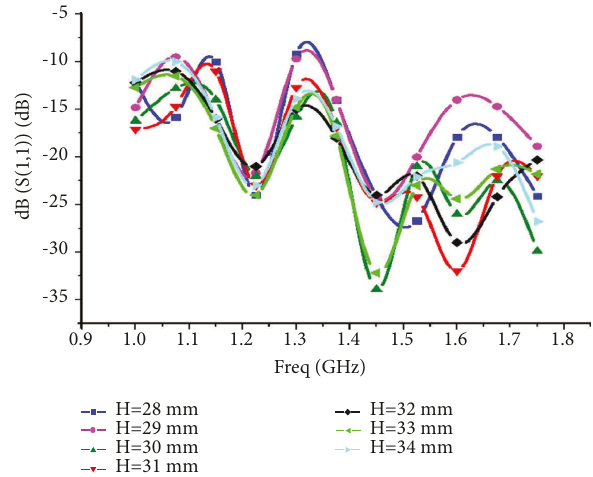
Figure 6: S 11 at various dipole heights.